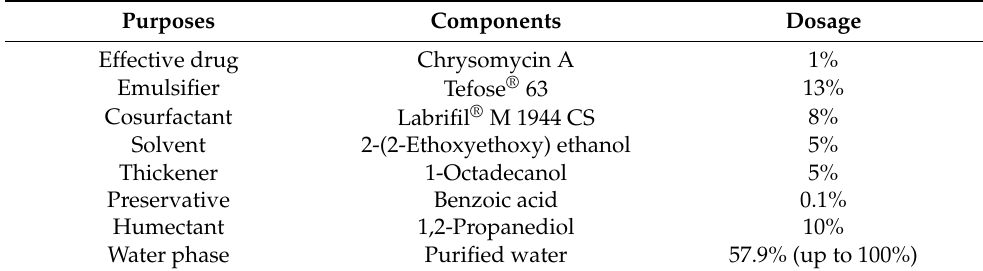
Table 4. The optimal